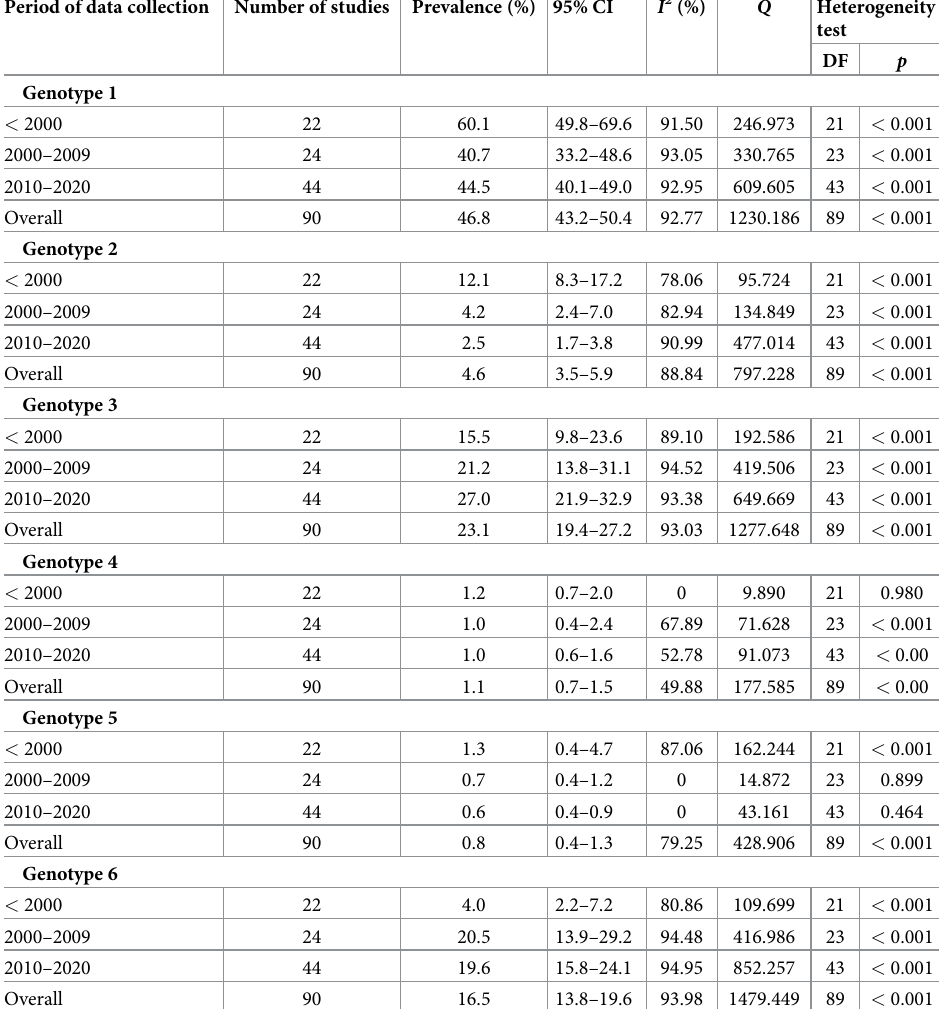
Table 3. Subgroup analysis for comparison of genotype distribution in Southeast Asia based on the period of data collection. Period of data